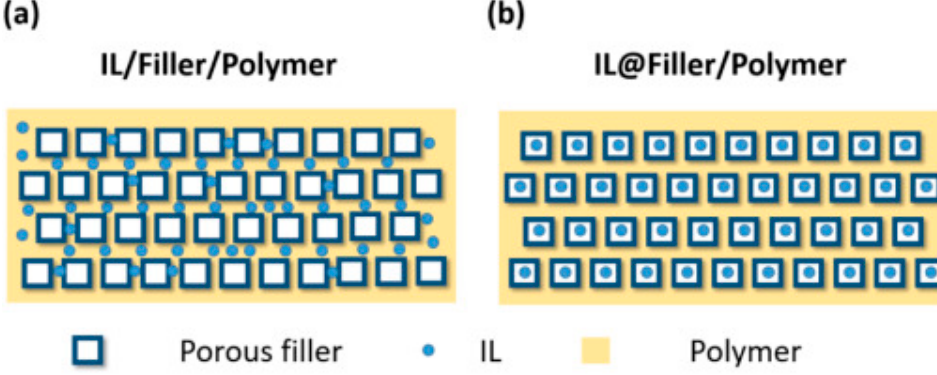
Figure 6. Structures of MMMs with ionic liquid (IL) and porous metal organic framework (MOF) ( a ) Free IL dispersed in filler / polymer matrix, ( b ) IL confined in the porous MOF fillers. Reprinted from fillers: ( a ) Free IL dispersed in filler/polymer matrix, ( b ) IL confined in the porous MOF fillers. Ref. [84] with permission from Reprinted from Ref. [84] with permission from Elsevier.